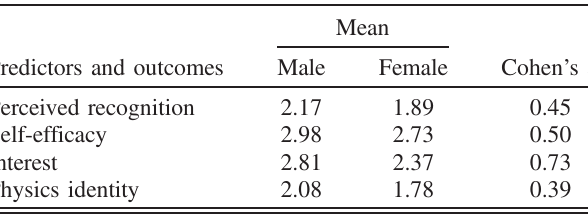
TABLE III. Mean postpredictor and outcome values in physics 1 by gender as well as statistical significance ( p values) and effect sizes (Cohen ’ s d) by gender. 563 matched students are included with 361 women and 202 men. All p values < 0 . 001